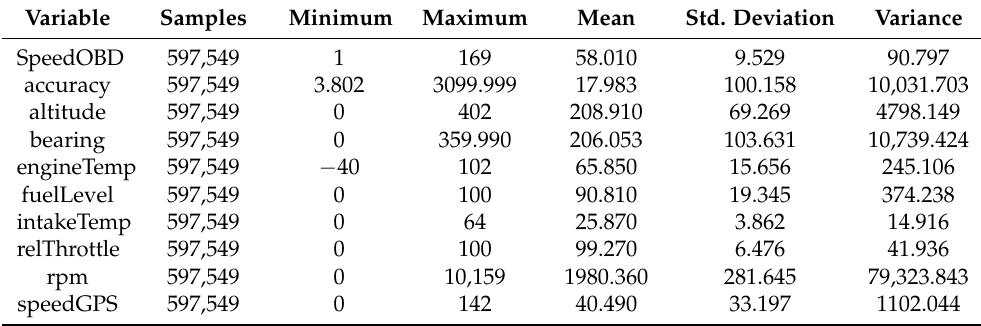
Table 3. Data statistics